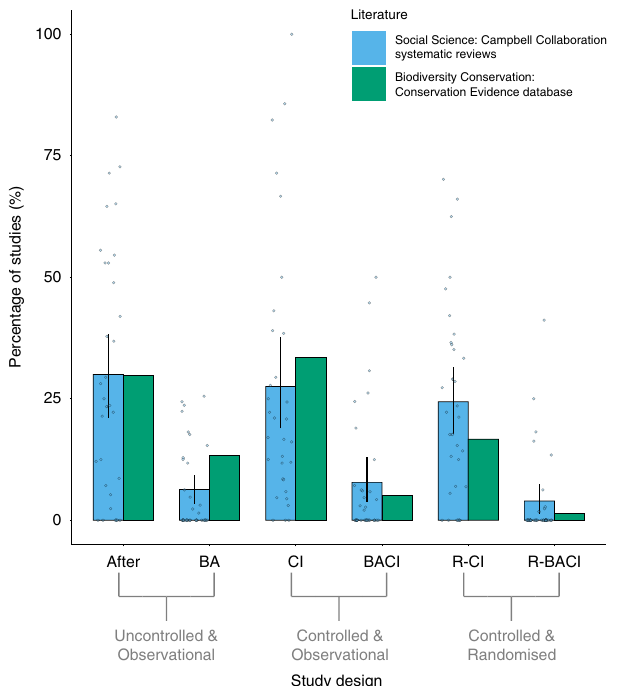
Fig. 2 Percentage of intervention studies with different study designs in the biodiversity-conservation and social-science